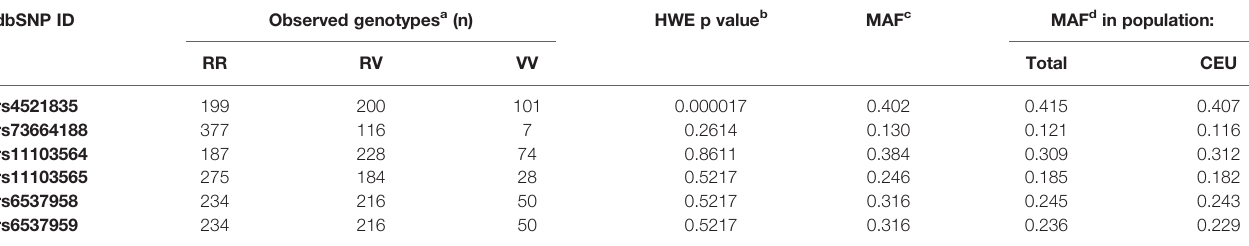
TABLE 4 | The frequencies of analyzed FCN2 3 ’ UTR genetic variants in polish preterm babies. dbSNP